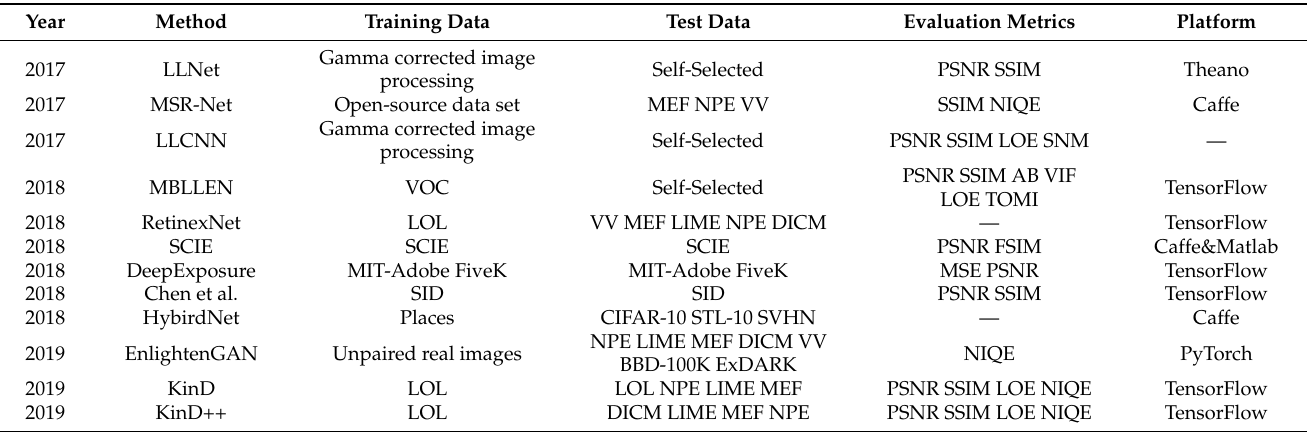
Table 1. Summary of essential features of deep-learning-based methods. “—” means this item is unavailable or not indicated in the corresponding